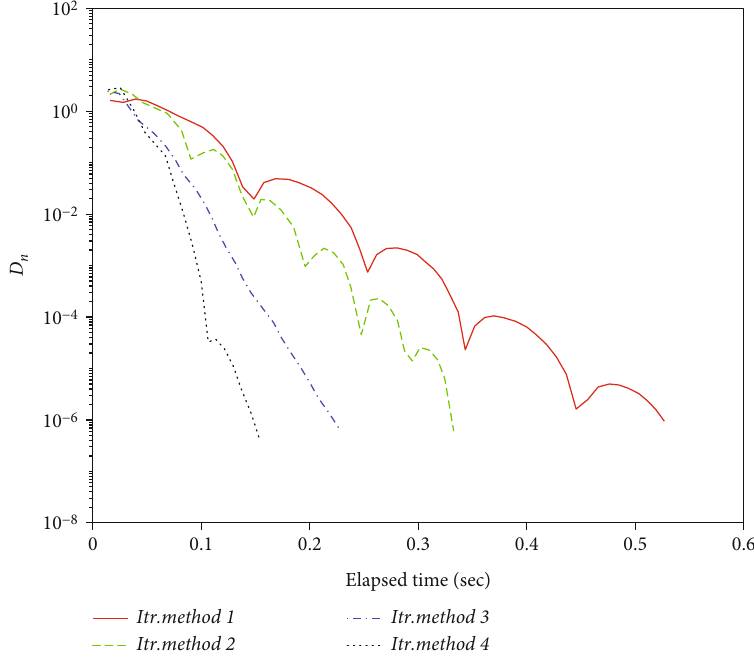
Figure 6: All methods are compared computationally while x